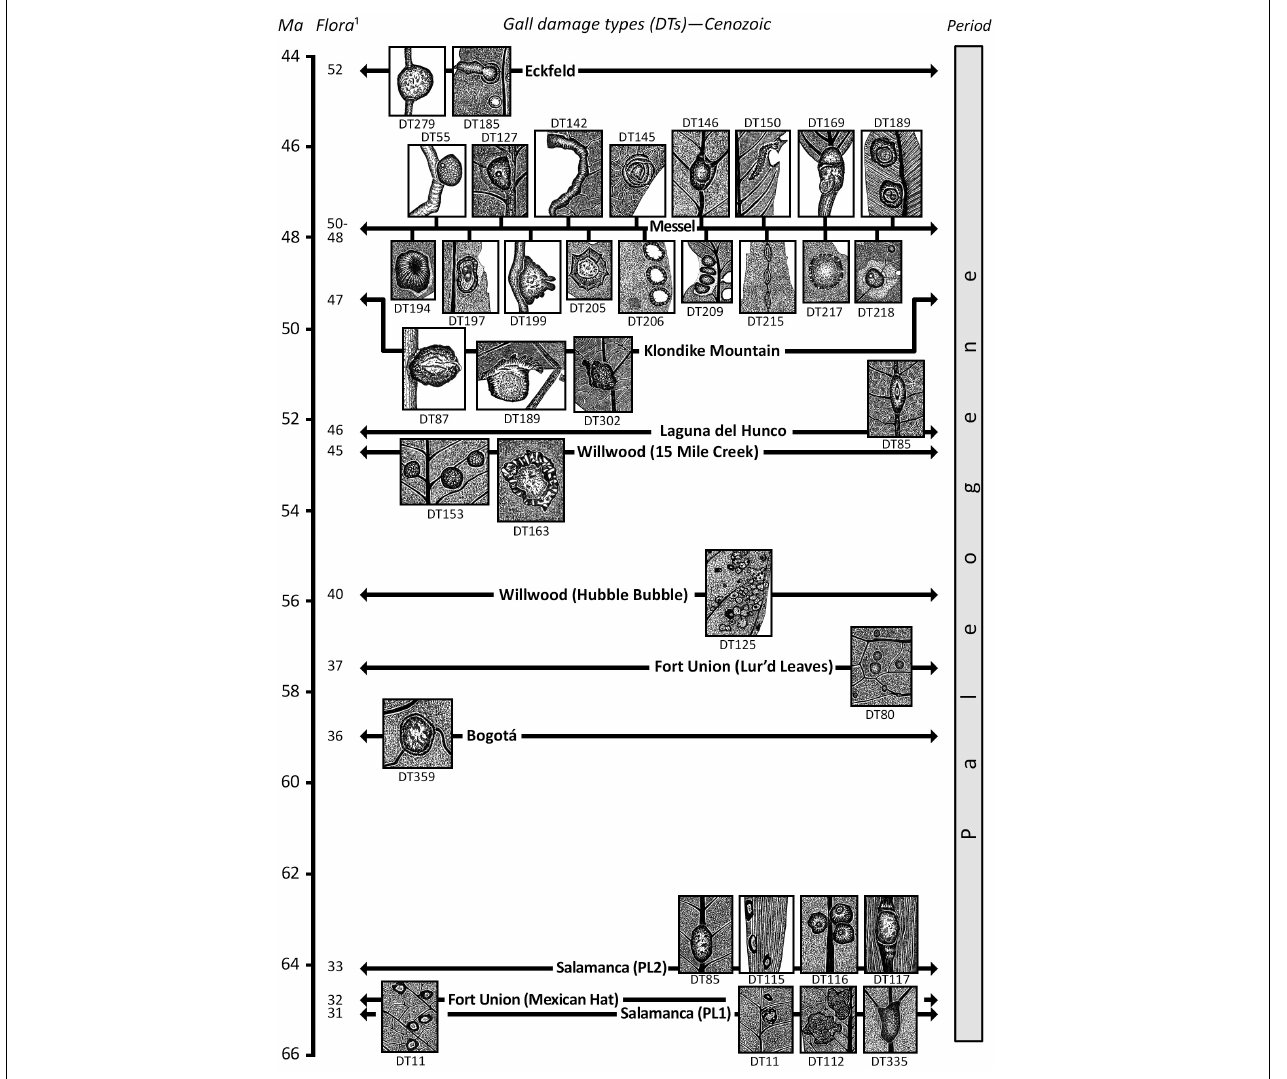
FIGURE 4 | Prominent gall damage types (DTs) for Cenozoic floras. See Supplementary Appendix 3 for documentation. Time scale after Walker et al.